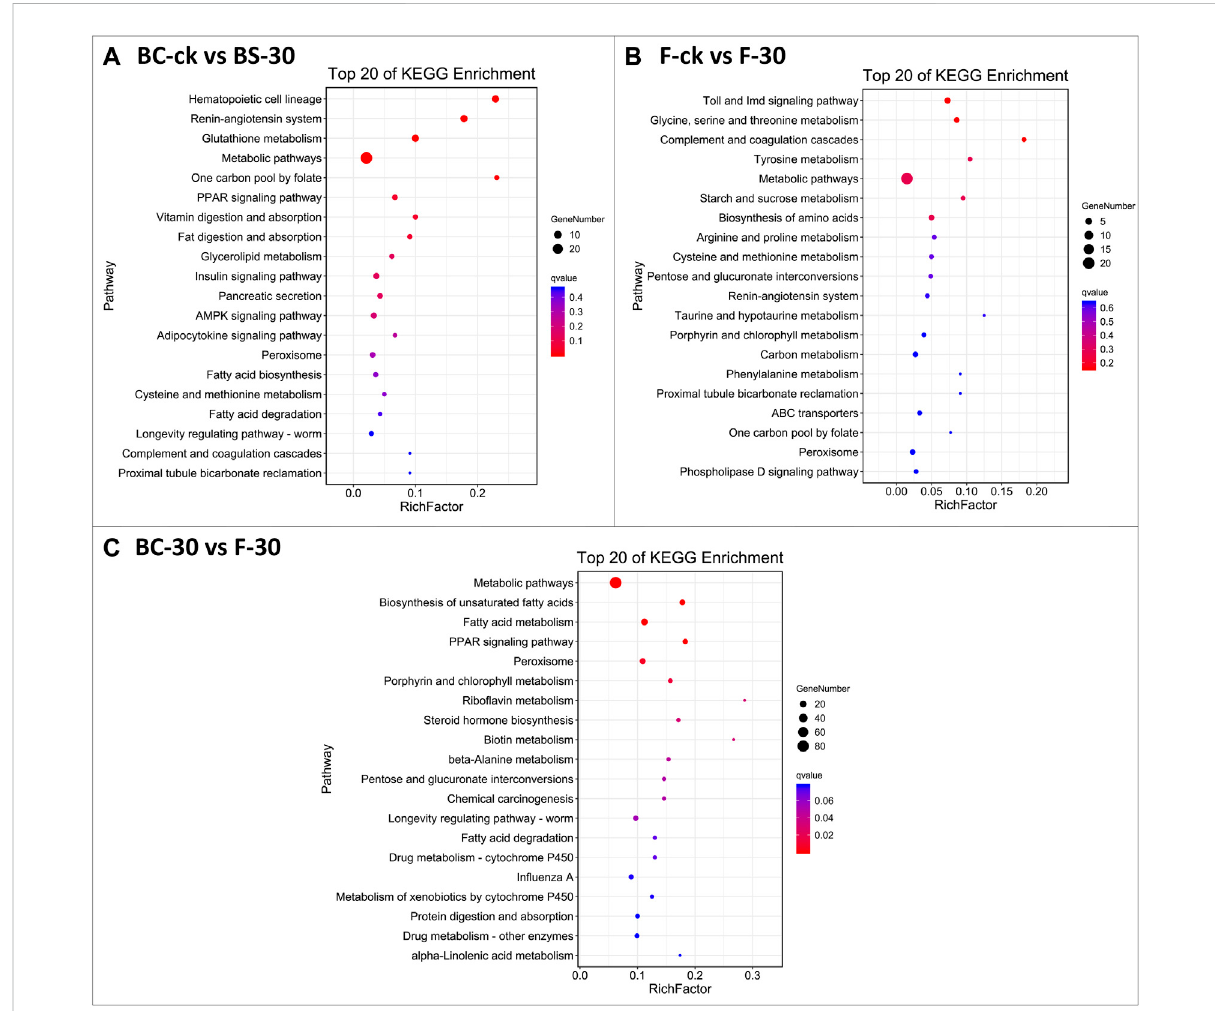
FIGURE 4 ThemostenrichedKyotoEncyclopediaofGenesandGenomes(KEGG)pathwaysof S.invicta (A) BC-ckvs.BC-30 (B) F-ckvs.F-30,and (C) BC- 30 vs. F-30. The signi fi cance of pathways is indicated by the q-value (color bar), the rich factor (X-axis), and the circles indicating the numbers of differentially regulated